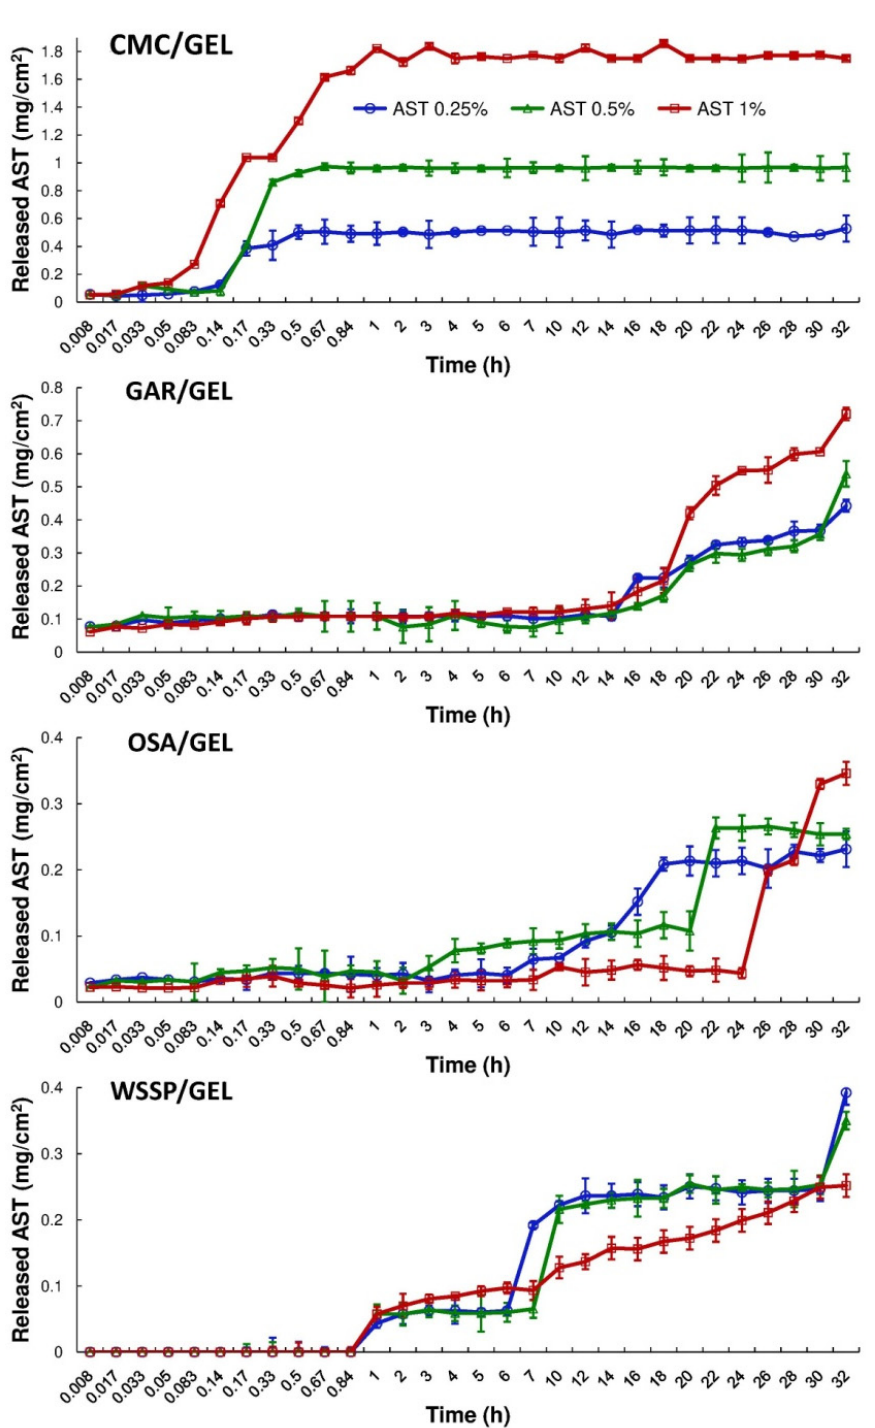
Figure 3. Cumulative migration of AST from the binary polysaccharide/GEL blend films into the water at 25 ◦